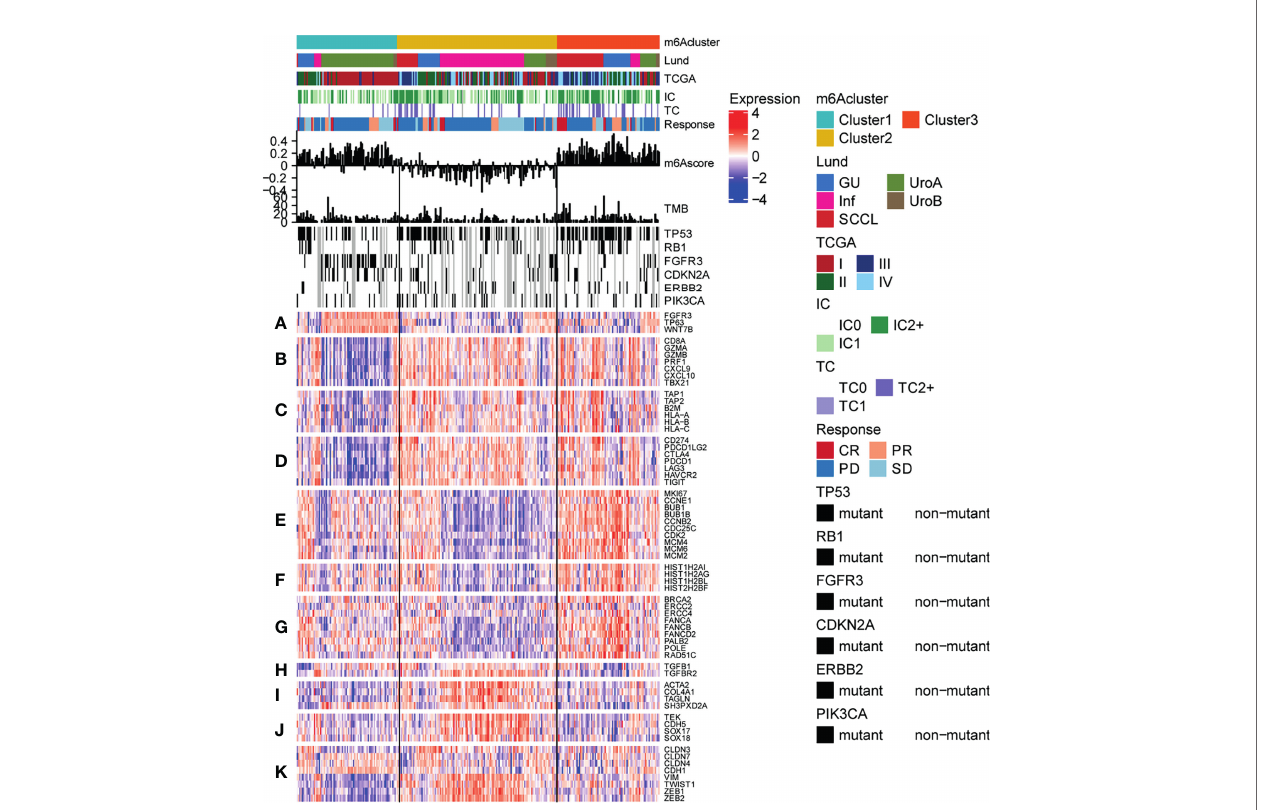
FIGURE 7 | Characteristics of m 6 A modi fi cation in anti-PD-L1 immunotherapy cohort of bladder cancer. Heatmap representing all patients evaluated for anti-PD-L1 response, First, the sequence was based on the modi fi ed mode of m 6 A, next by the molecular subtype, PD-L1 expression on cells (IC), PD-L1 expression on cells (TC), and the reaction to atezolizumab. The m 6 Ascore and TMB levels of each patient are shown, and the mutation status of several genes of interest (black, mutation; gray, patients without mutation data) are shown. In addition, the lines of the heat map show the expression of the genes of interest (z-score), which are divided into the following biological classes and/or pathways: (A) FGFR3 gene signature; (B) CD8 Teff signature; (C) antigen-processing machinery; (D) immune checkpoint signature; (E) MKI67 and cell cycle genes; (F) DNA replication-dependent histones; (G) DNA damage-repair genes; (H) TGF b receptor and ligand; (I) F-TBRS genes; (J) EMT markers; (K) angiogenesis